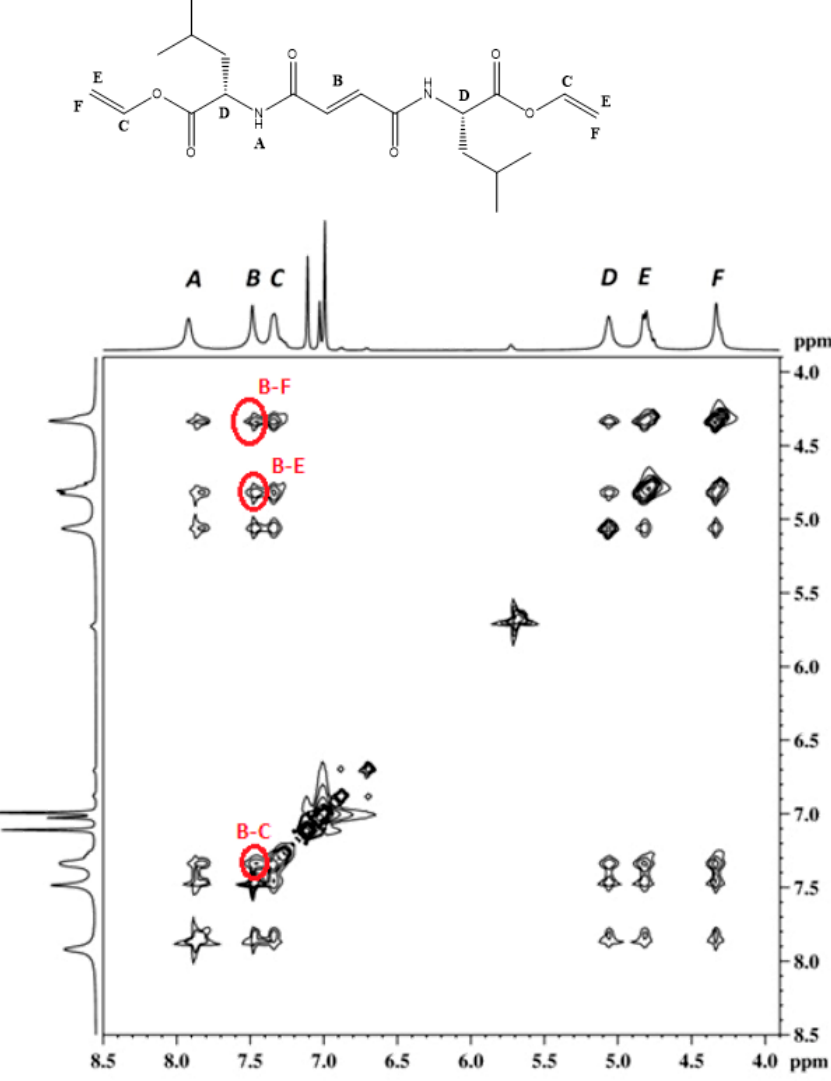
Figure 4. 2D 1 H NOESY spectra of 1a toluene-d 8 gel.